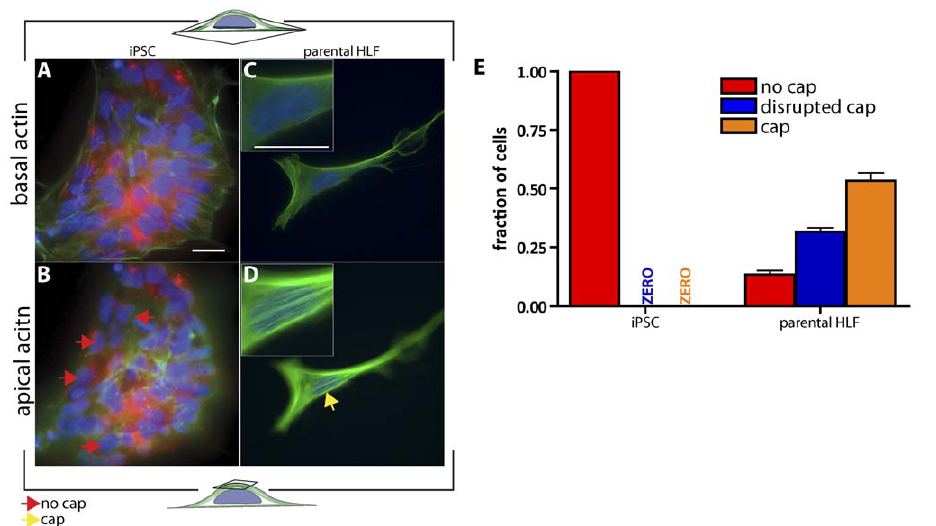
Figure 4. Perinuclear actin cap is absent in human induced pluripotent stem cells (iPSCs), but is present in parental cells from which they are derived. A–D. Typical organization of basal stress fibers (A and C) and perinuclear actin cap (B and D) in iPSCs (A and B) and parental HLFs (C and D) from which they were derived. Red and yellow arrows indicate examples of cells showing no actin cap and a well-organized actin cap, respectively. Insets , details of the basal (top inset) and apical (bottom inset) organization of the actin filament network in a HLF. Scale bar, 20 m m. E. Proportion of iPSCs and HLFs showing either an organized actin cap (orange bars), a disrupted actin cap (blue bars), or no actin cap (red bars). At least 200 cells were probed in triplicate for a total of 600 cells for each case.